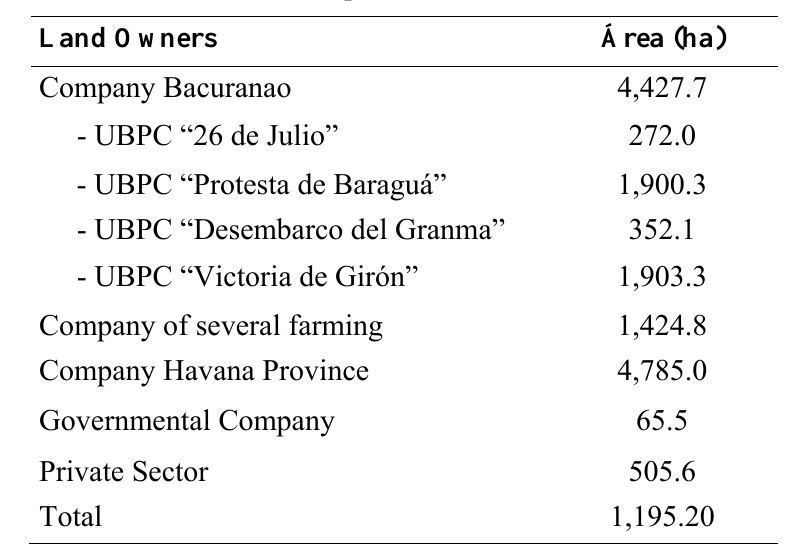
Table 7. Land Ownership in the Itabo and Guanabo